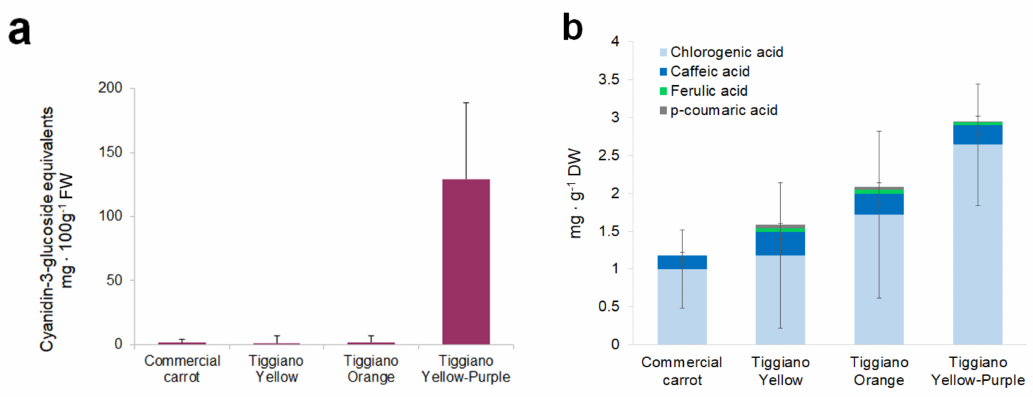
Figure 2. ( a ) Anthocyanins and ( b ) phenolic acids content in Tiggiano carrots compared to a commercial cultivar. Data are expressed as means ( n = 3) ±